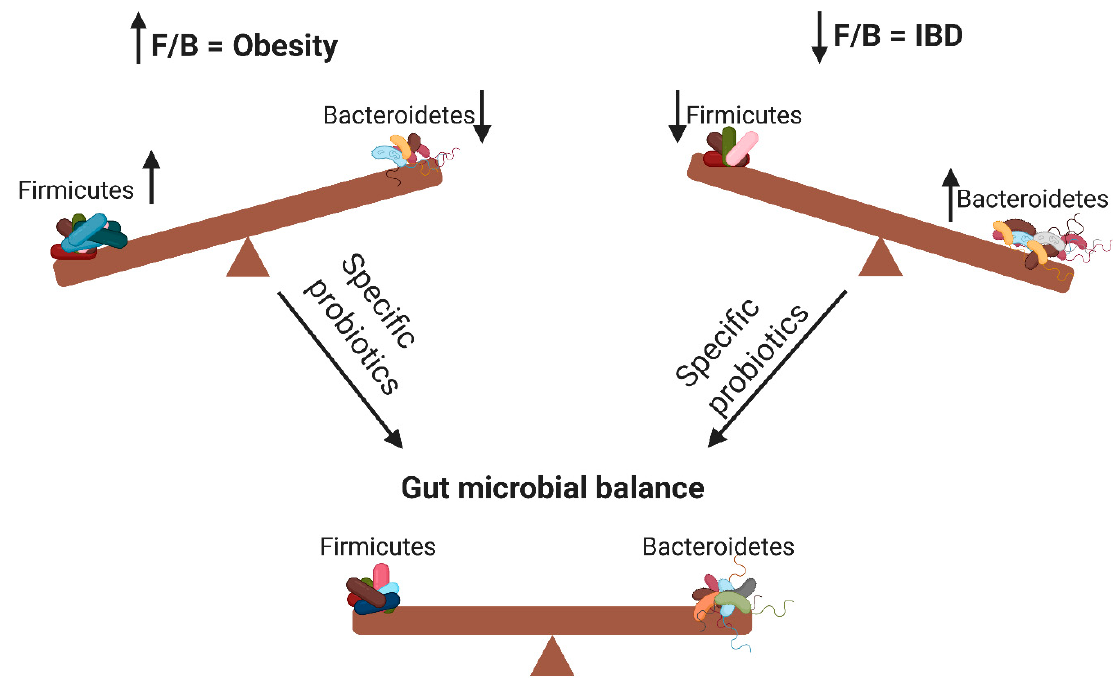
Figure 1. Changes in the Firmicutes/Bacteroidetes (F/B) ratio can cause obesity or inflammatory bowel disease. Specific probiotics can restore the gut microbial balance by influencing the F/B ratio. ↑ means increase; ↓ means decrease.